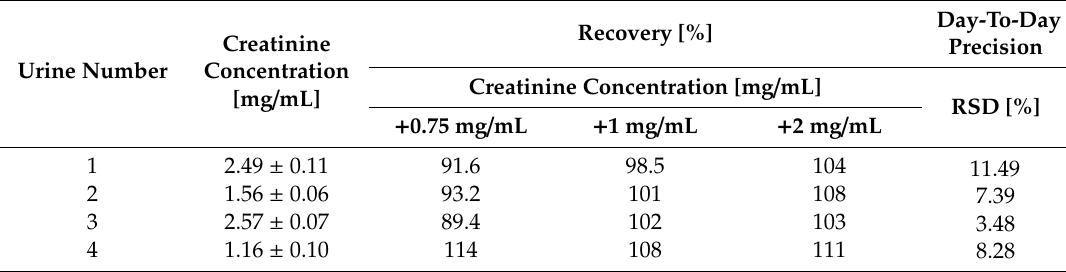
Table 1. The recovery (calculated as a difference between added creatinine standard and creatinine concentration in urine) and day-to-day precision (four injections per sample, each day on five different days within two weeks) of the HPLC method.